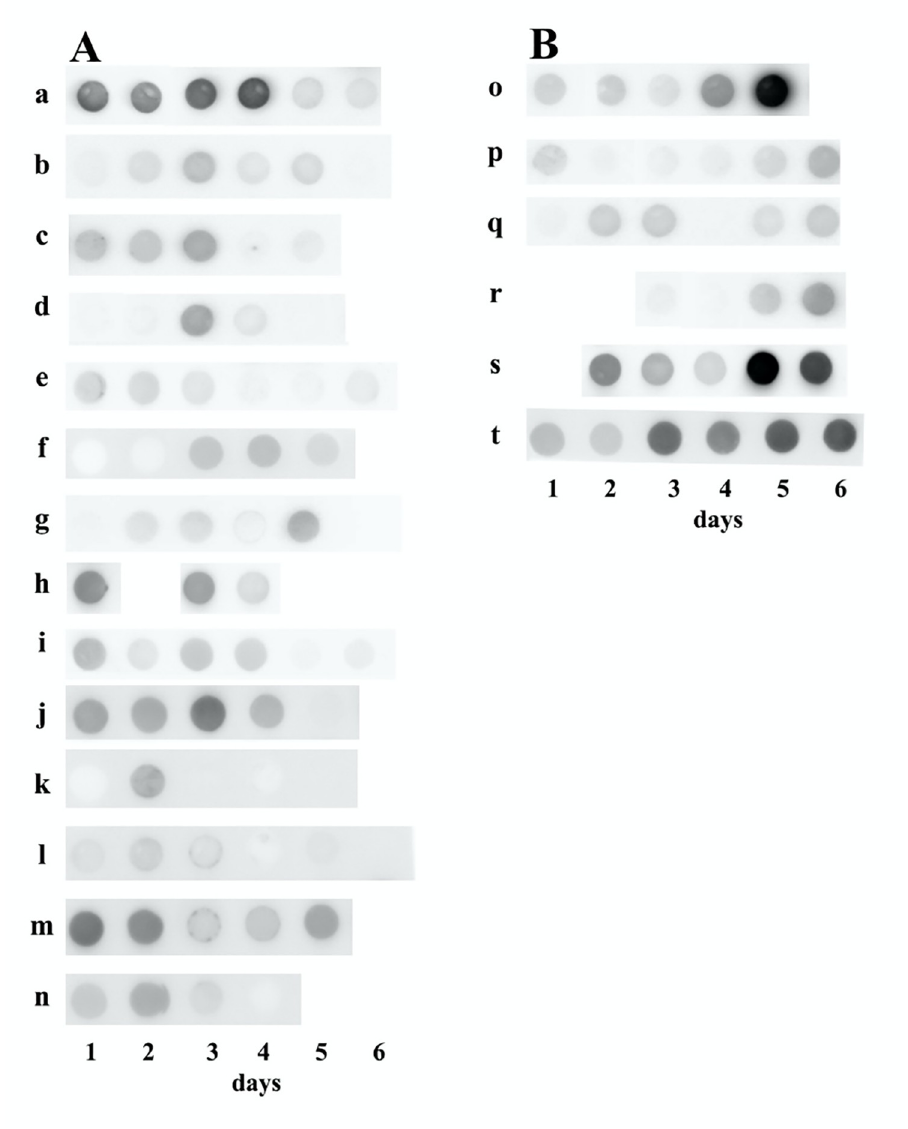
Fig 1. C3a/C3 dot blot. Urine samples obtained at consecutive time points from ICU patients suffering from serious infections. Patient ( o ) did not survive this episode due to multiorgan failure the same day as urine sample #5 was collected. Shown is a representative experiment out of four. Left panel of the figure represents patients with decreasing urinary C3a/C3 levels. Right panel shows patients with increasing urinary C3a/C3 levels towards 5 th and 6 th day of ICU